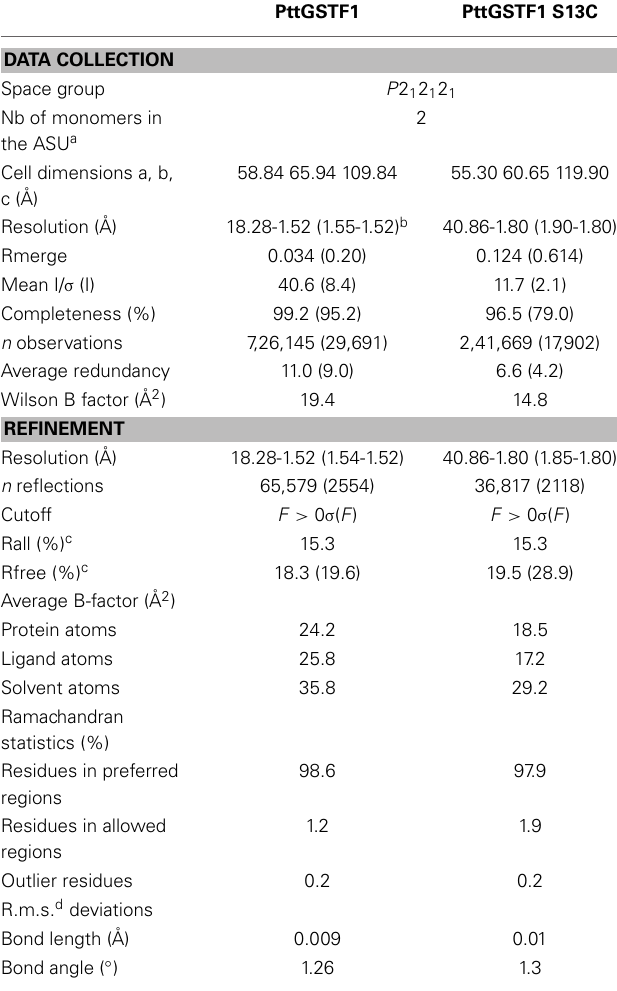
Table 1 | Statistics of X-ray diffraction data collection and model